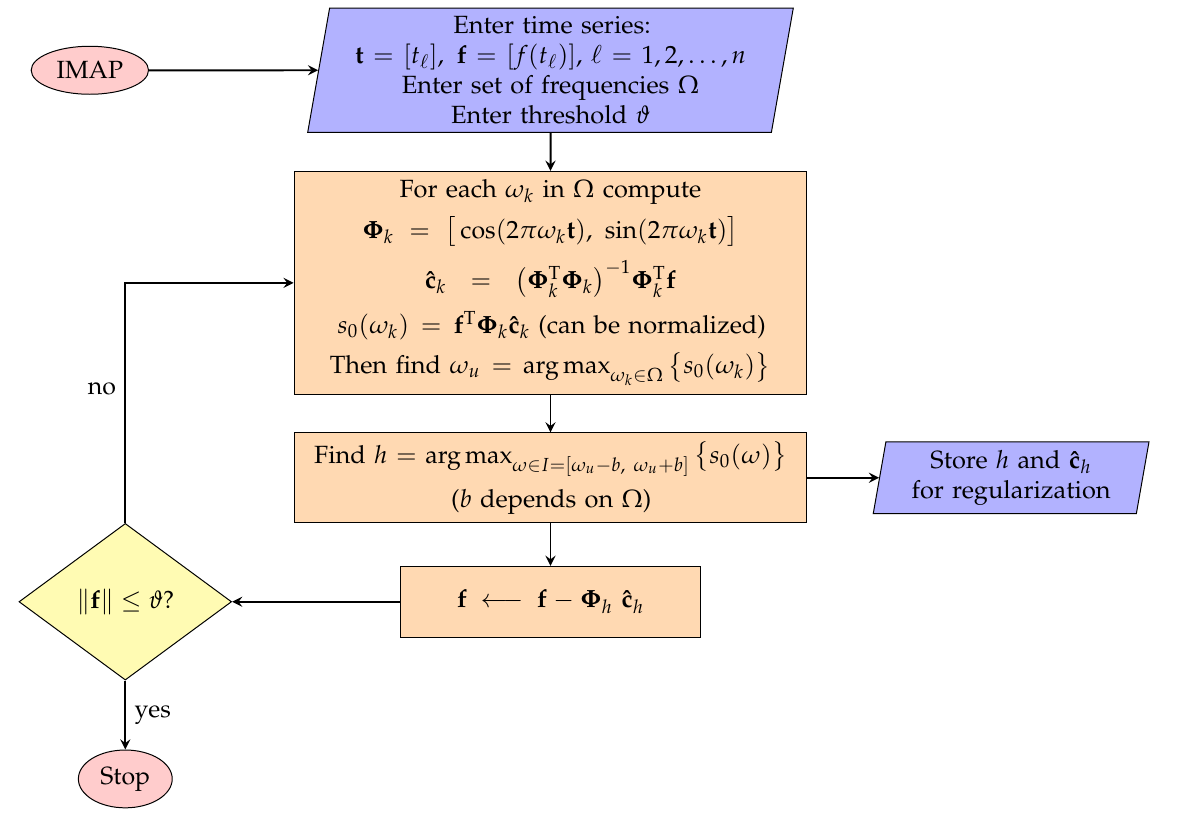
Figure A3. A flowchart of the IMAP algorithm in matrix